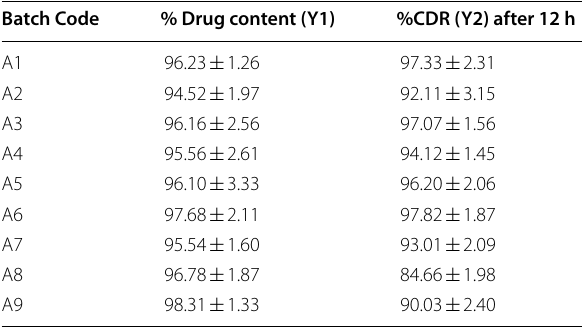
Values are mean